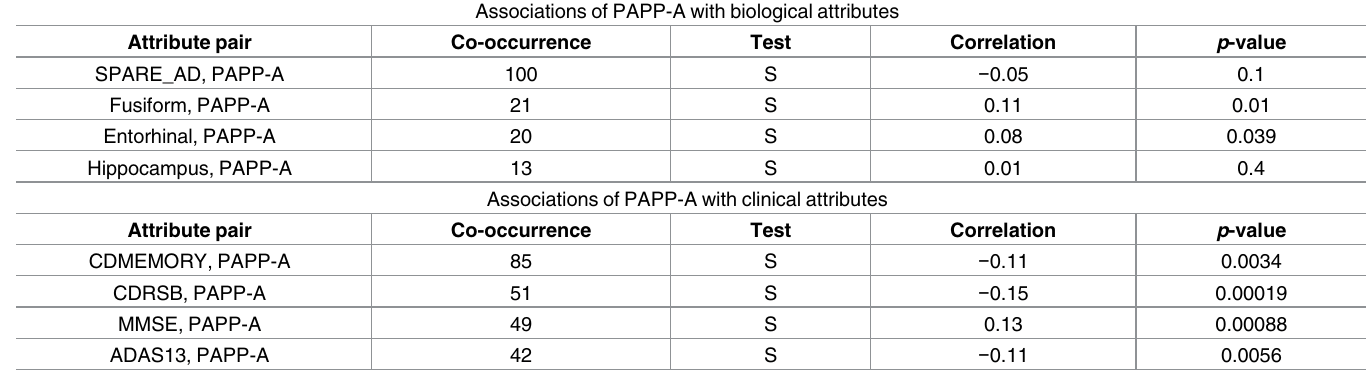
Table 10. The top four associations of PAPP-A with other attributes based on attribute pair occurrences in redescription queries obtained by using constraint-based redescription mining on dataset D 3 . S denotesSpearman’scorrelationcoefficient. The producedredescription set contains100 different